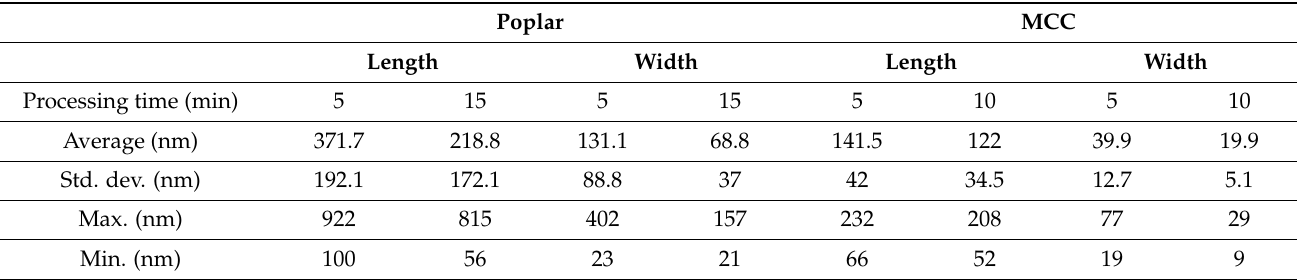
Table 1. Size distribution (length and width) of cellulose nanocrystals (CNC), sourced from either poplar or microcrystalline cellulose (MCC), measured from TEM photos showcased previously.